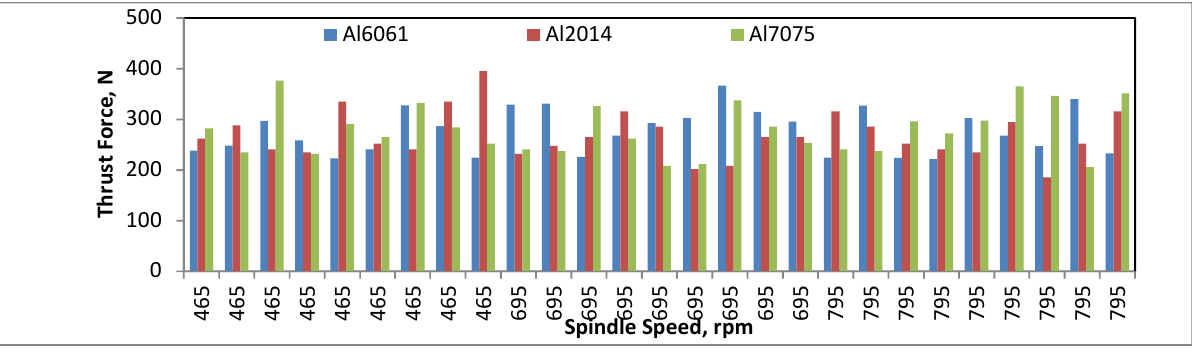
Fig. 9 . Influence of variation of the spindle speed on thrust